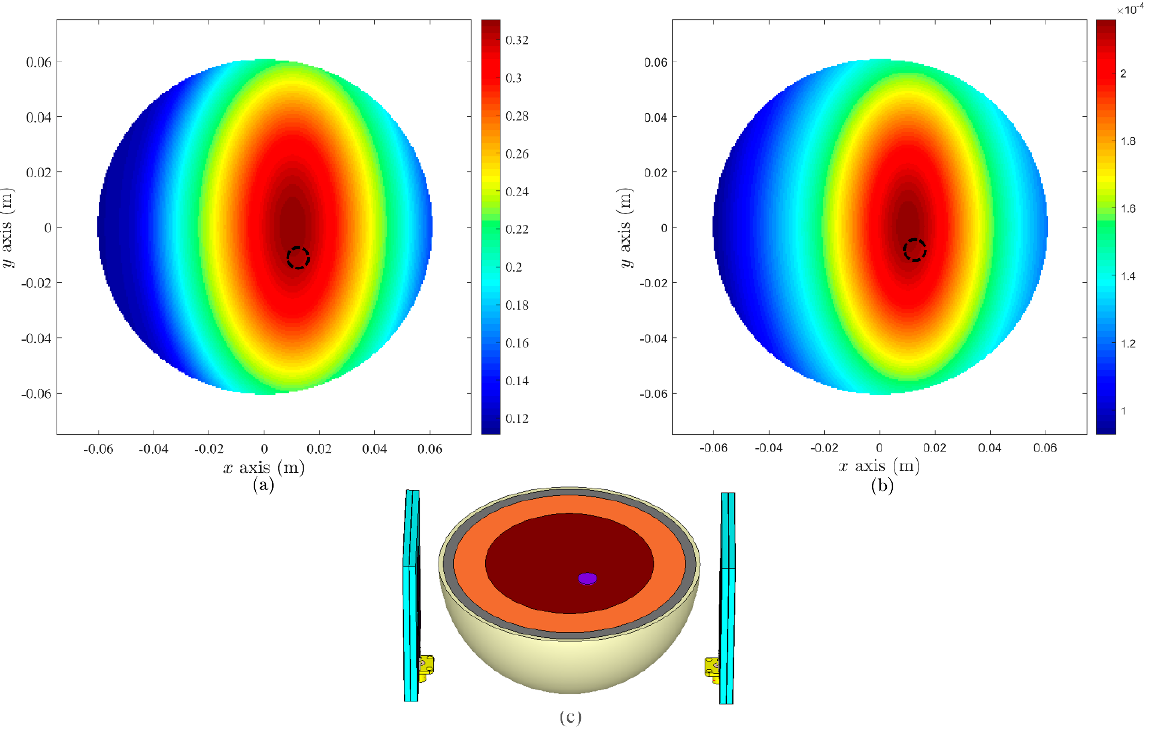
Figure 19. MWI results based on two antennas in simulation: ( a ) DAS, ( b ) DMAS algorithms, and ( c ) depiction of simulated setup.